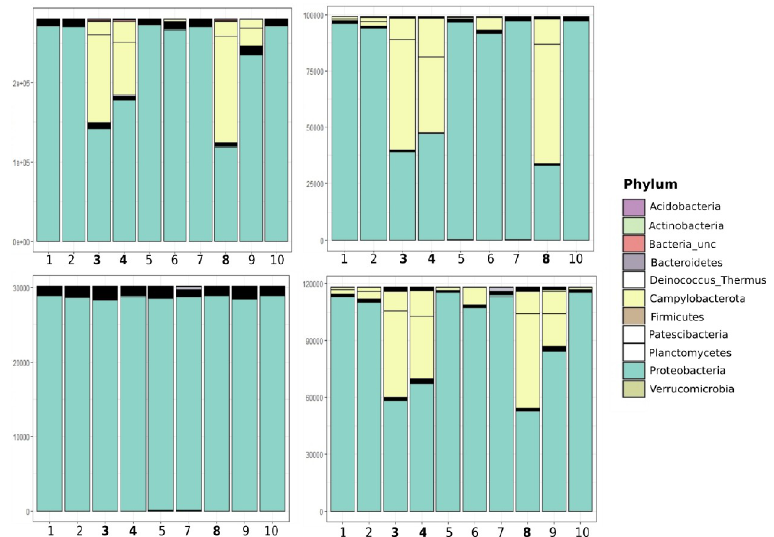
Fig 6. Phylum-level diversity per sample recovered by four primer sets. Phyla abundances as assigned with Mothur and the SILVA v132 reference database. Each panel represents a different primer set (ps1-ps4). The y-axis represents number of OTUs x1000. 1 = MAS100, 2 = MAS109, 3 = MASM22, 4 = MASM30, 5 = MASM34, 6 = MASM36, 7 = MASM45, 8 = MASM5, 9 = MAS538, 10 = MAS562. NCS samples are shown in bold on the x axis.